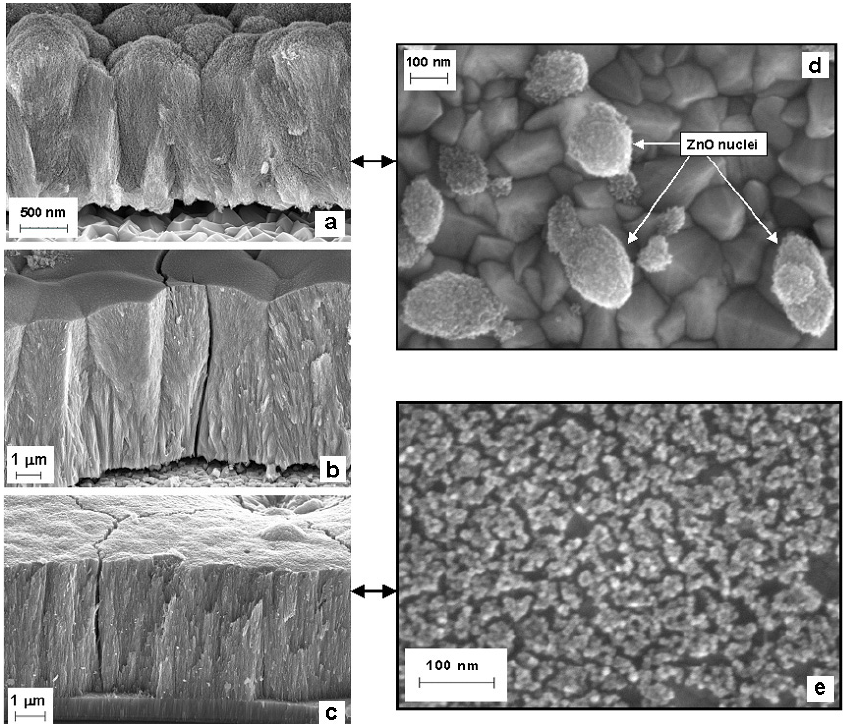
Fig. 1. SEM images of ZnO mesoporous structure deposited on (a) FTO glass, (b) a 400 nm thick bulk ZnO buffer layer deposited on FTO glass and (c) sputtered Al:ZnO. Deposition of the nanoporous structure on (d) FTO glass and (e) Al:ZnO respectively after deposition of 0.01 C/cm 2